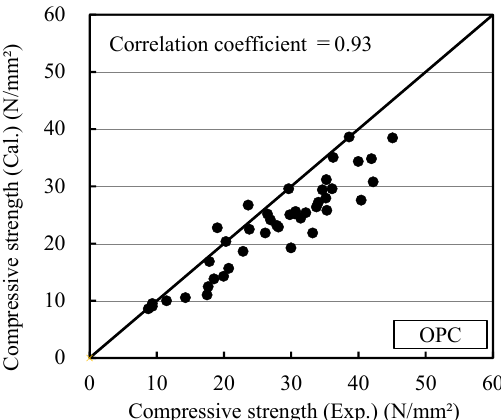
Figure 5. Measured compressive strength and calculated compressive strength (OPC): Previous equation for maturity.